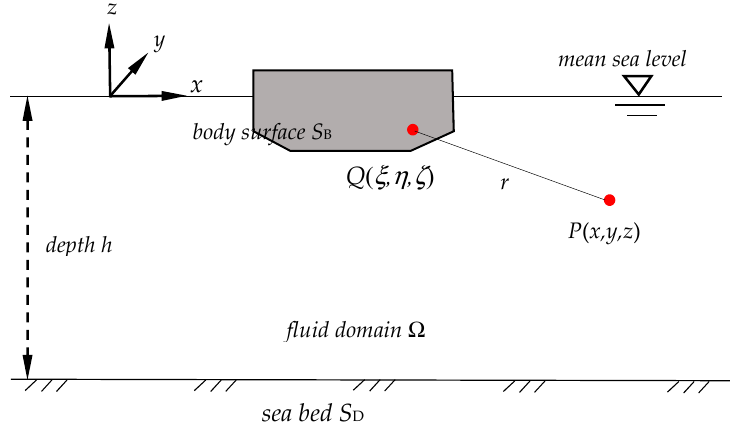
Figure 1. Definition of the coordinate system in the three-dimensional space. Q denotes the source point on the immersed body boundary S B , and P denotes the field point anywhere in the fluid domain.